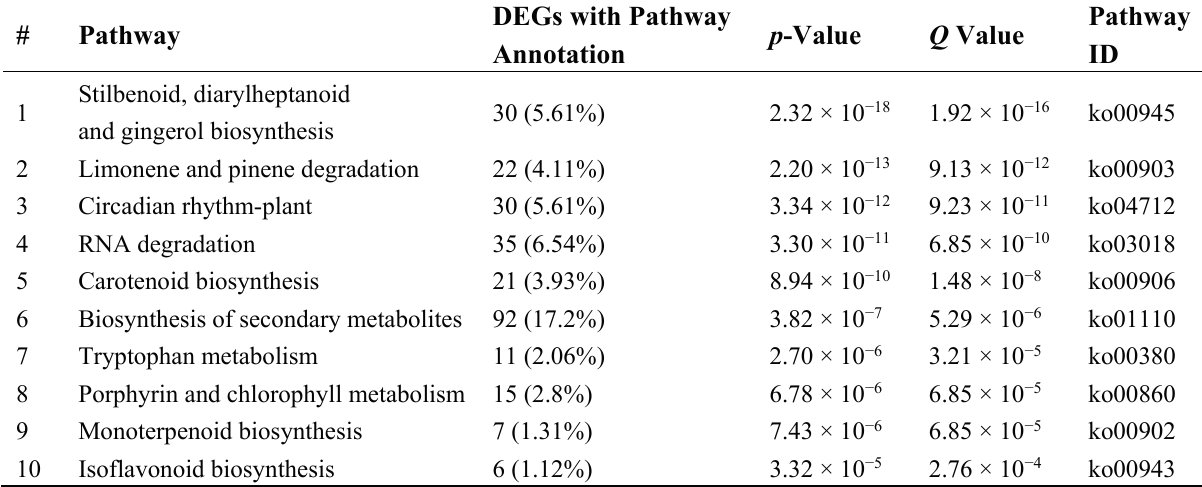
Table 5. TOP 10 KEGG pathway analysis results for the P. fortunei